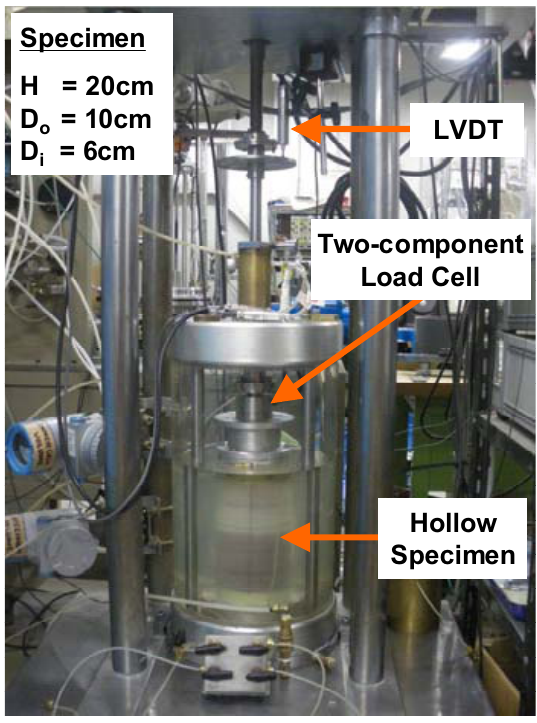
Fig. 2. General layout of specimen in torsional shear